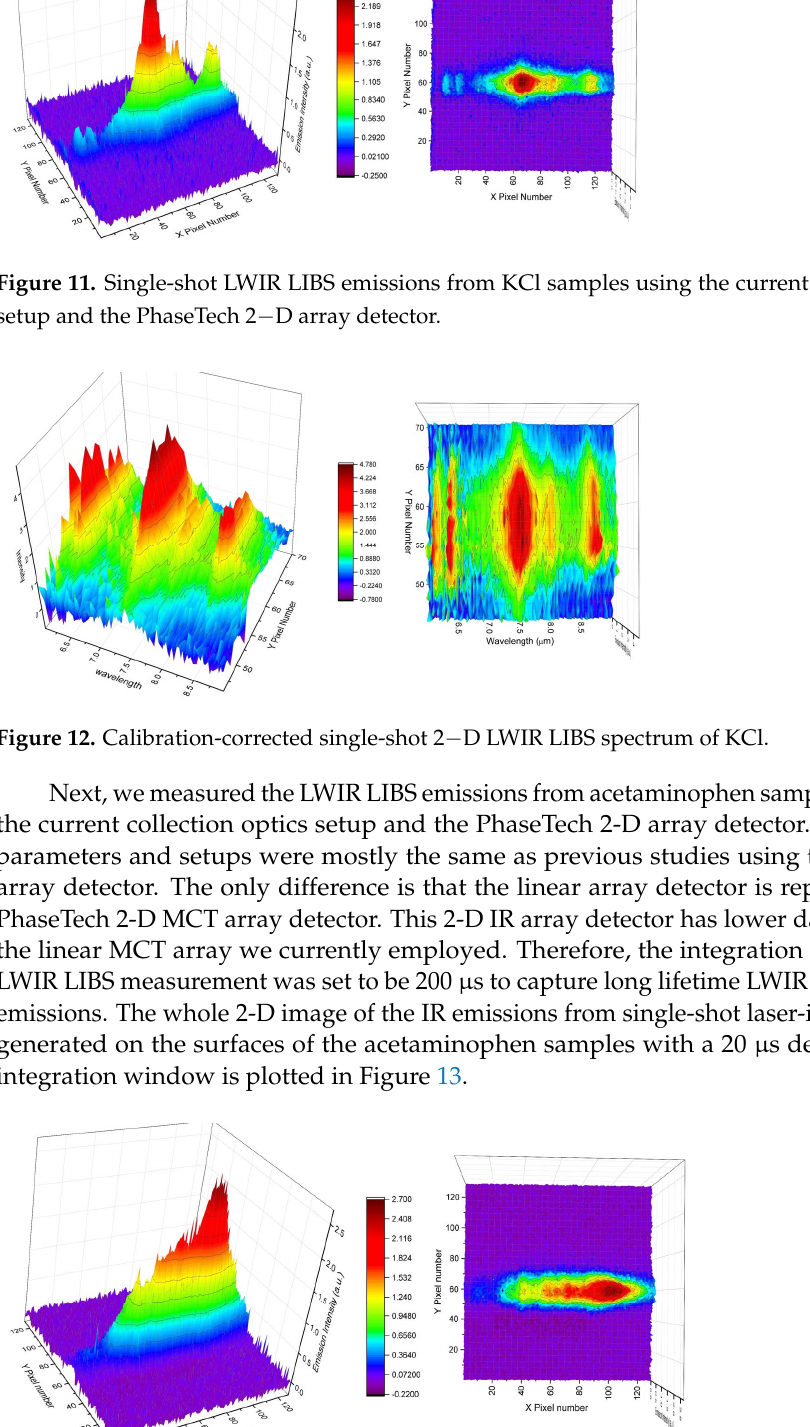
Figure 13. Single-shot LWIR LIBS emissions from acetaminophen tablets using the current collection optics setup and the PhaseTech 2 − D array detector. The LWIR LIBS emissions of acetaminophen were centered near row Y58 on the 2-D array detector with the FWHM spanning about 14 pixels (sampling at row X70) in the direction perpendicular to the grating dispersion (Y-coordinate). Again, using the pixel pitch size and the magnification factors of the current setup, we estimated the dimension of the molecular LWIR LIBS emissions from acetaminophen to be around 2.5 mm on the sample surface along the axial direction perpendicular to the grating dispersion (i.e., per- pendicular to the plane of incidence). The nonuniformity- and wavelength-corrected 2-D spectrum of acetaminophen LWIR LIBS emissions is shown in Figure 14. All major vibra- tional signature emissions of acetaminophen in the 6–9 µm spectral range (Table 1) were clearly observed.